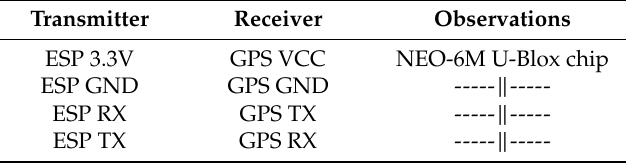
Table 1. Centralized data regarding the pin connections between the GPS module and ESP 32.